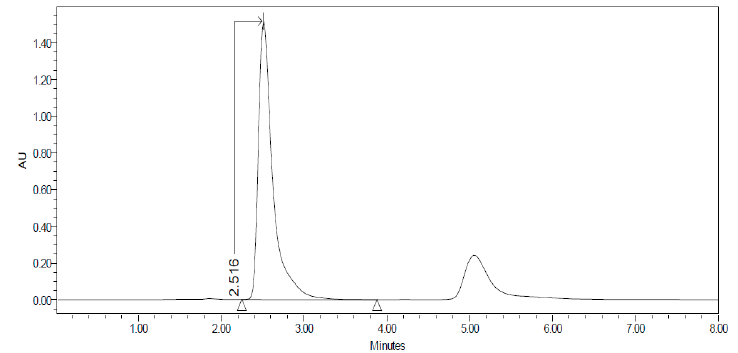
Figure 1. Chromatogram of the Carprofen (CP) validation line at concentration 100 µg/mL. Nanomaterials 2020 , 10 , x FOR PEER REVIEW